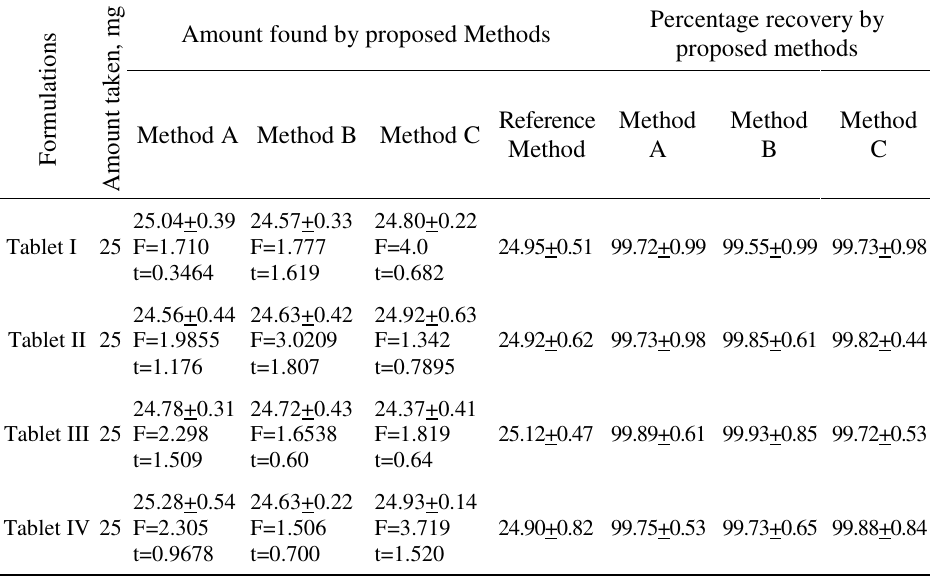
Table 3. Assay of BUCZ in pharmaceutical formulations. Amount found by proposed Methods